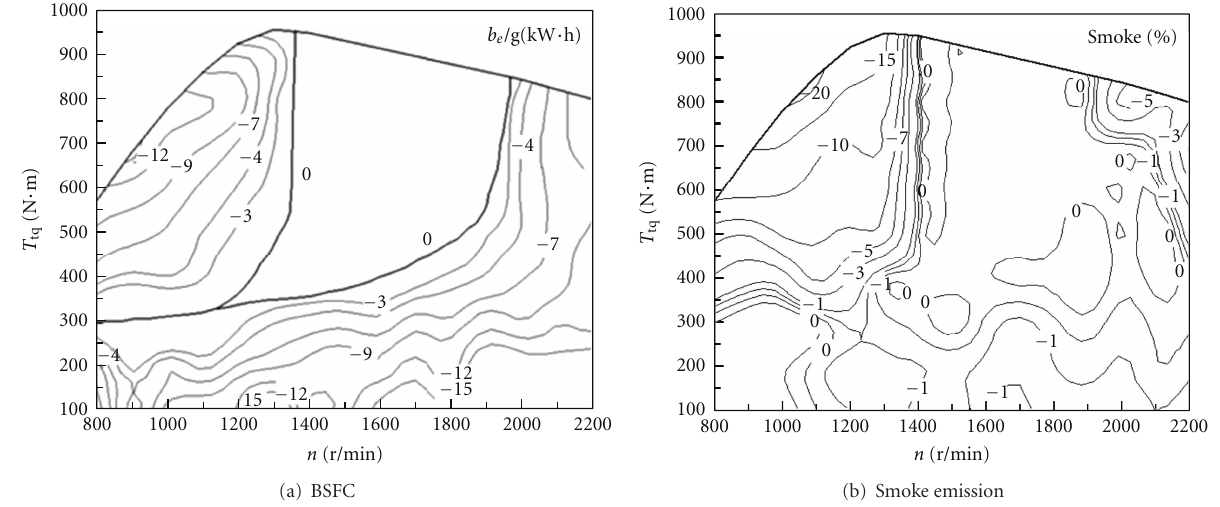
Figure 3: Comparison of BSFC and smoke emissions between the 3-phase ST and original TC.